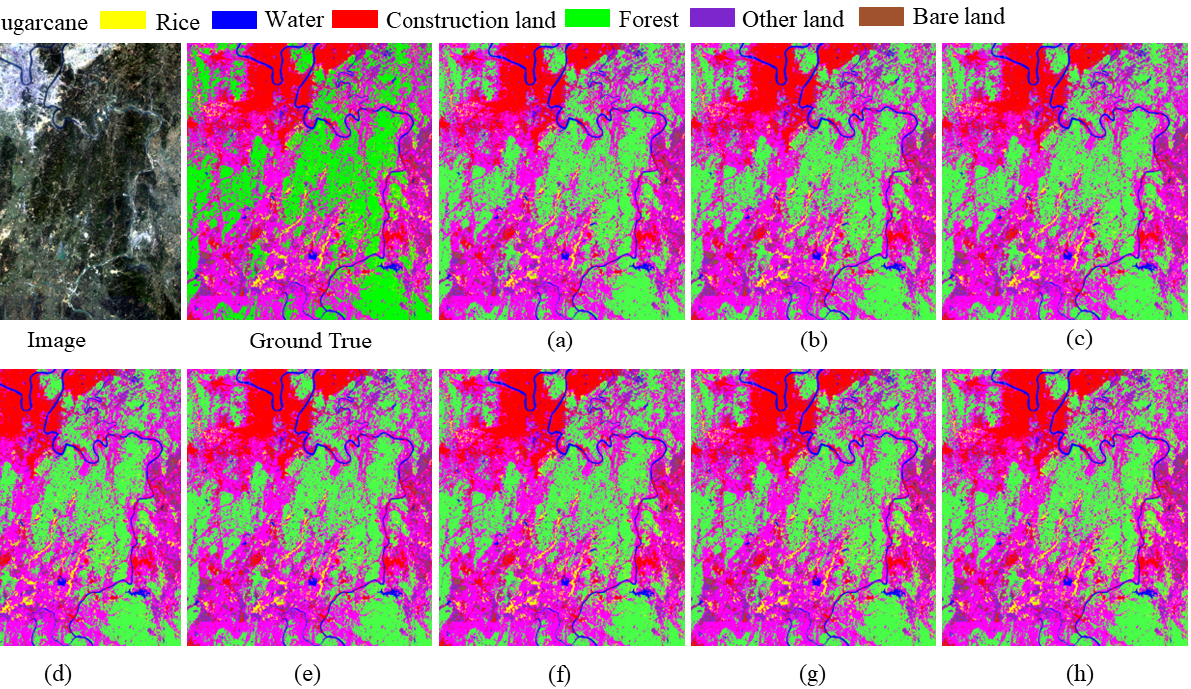
Figure 10. Semantic segmentation results on the test set in the dataset I produced by: ( a ) U-Net, ( b ) U-Net++, ( c ) SAR-UNet, ( d ) Res-UNet++, ( e ) Attention-UNet, ( f ) UCTransNet, ( g ) Swin-UNet, and ( h ) SA-UNet.